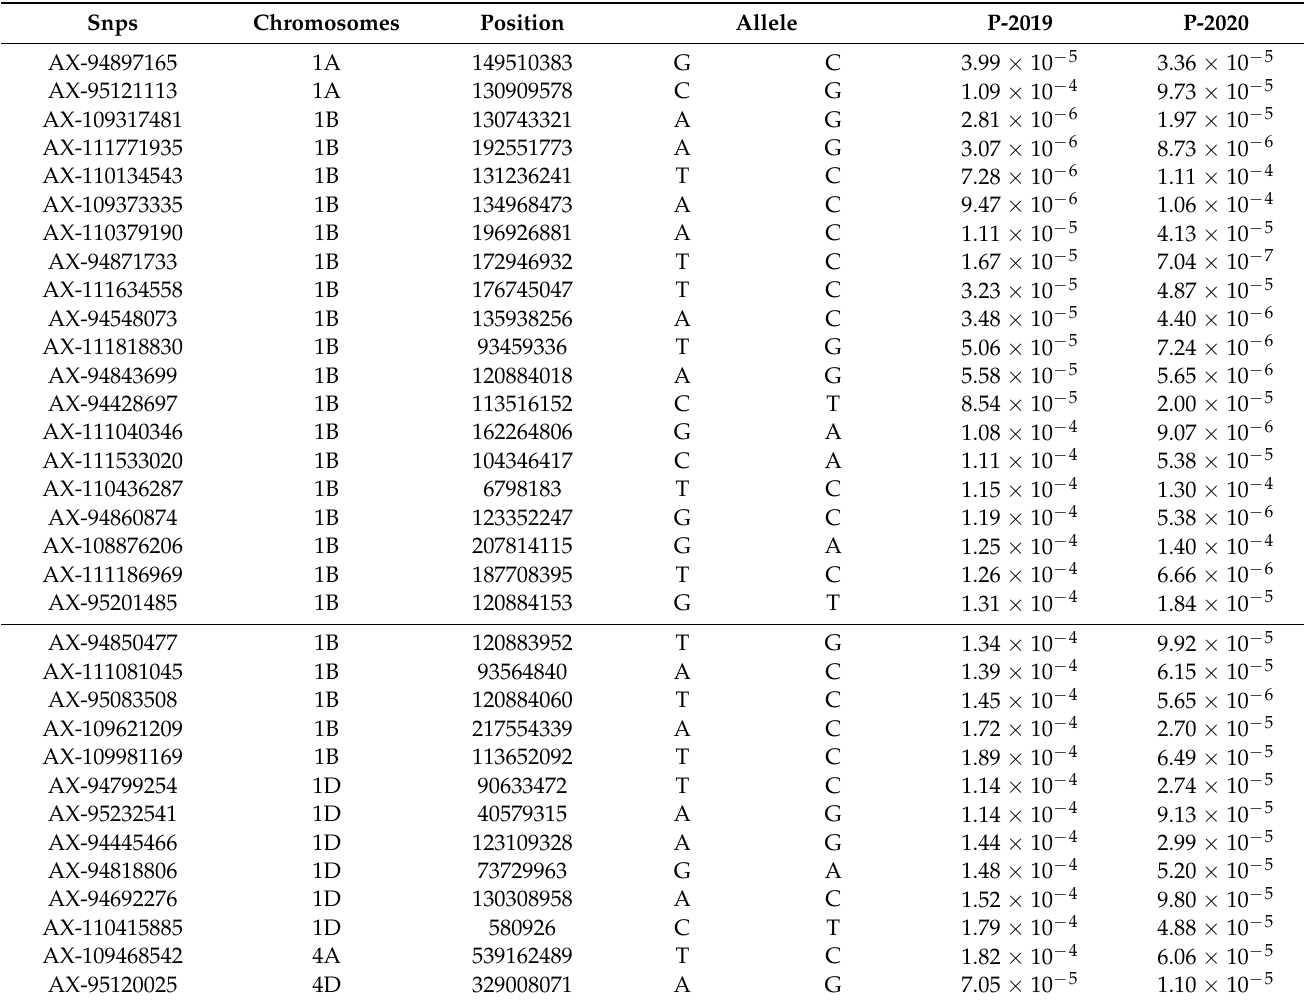
Table 3. SNPs significantly associated with both